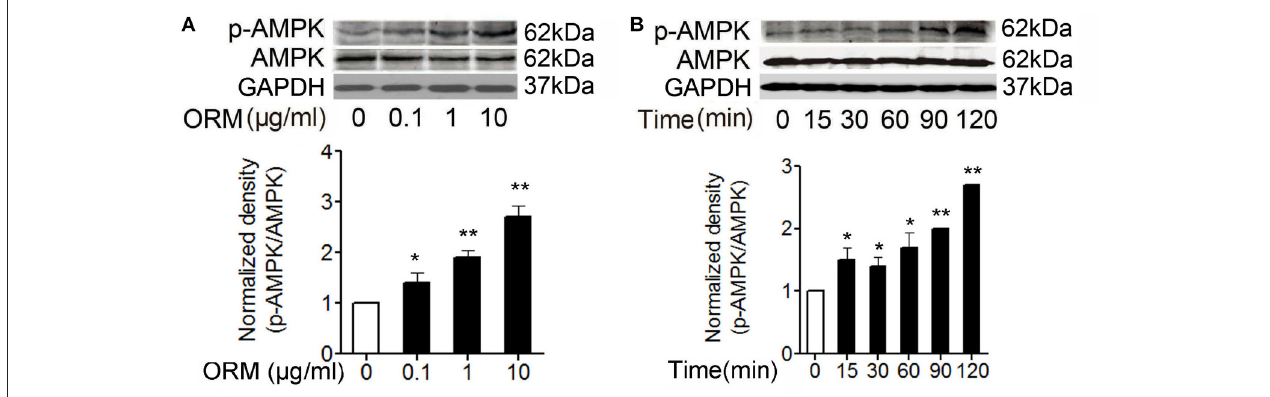
FIGURE 2 | ORM can induce the activation of AMPK in skeletal muscles. (A) Representative western blotting of p-AMPK and total AMPK and quantification of the result in C2C12 cells treated with indicated doses of ORM for 2h ( n = 3 per dose). (B) Representative western blotting of p-AMPK and total AMPK and quantification of the result at indicated time in soleus muscle tissues of mice treated with 200mg/kg of ORM via tail vein injection ( n = 6 per time point). All data are expressed as the mean ± s.d.* P < 0.05, ** P < 0.01 by one-way ANOVA with Dunnett’s post-hoc